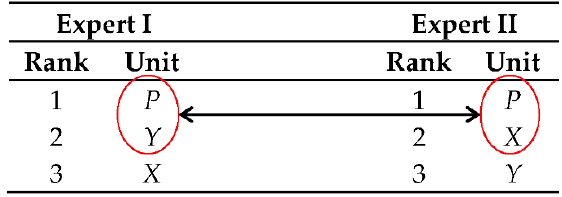
Figure 3. Direct contradiction between Experts I and II.